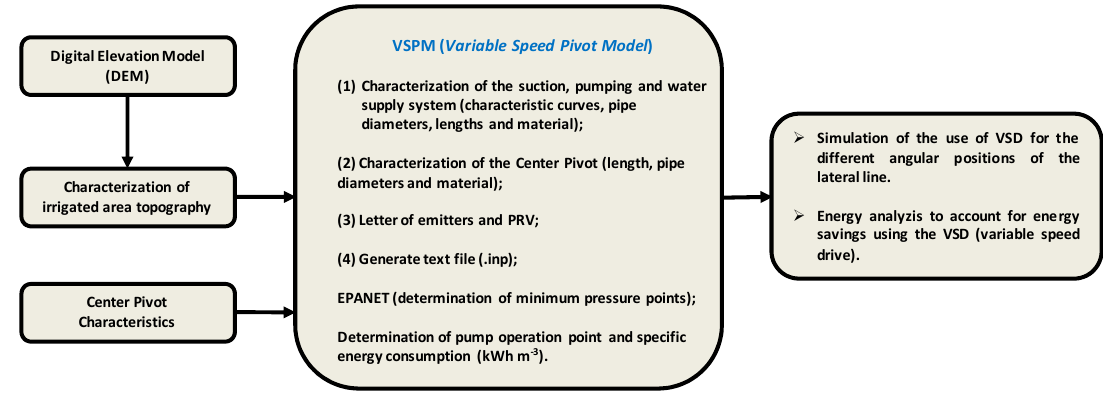
Figure 1. Diagram of the proposed procedure.